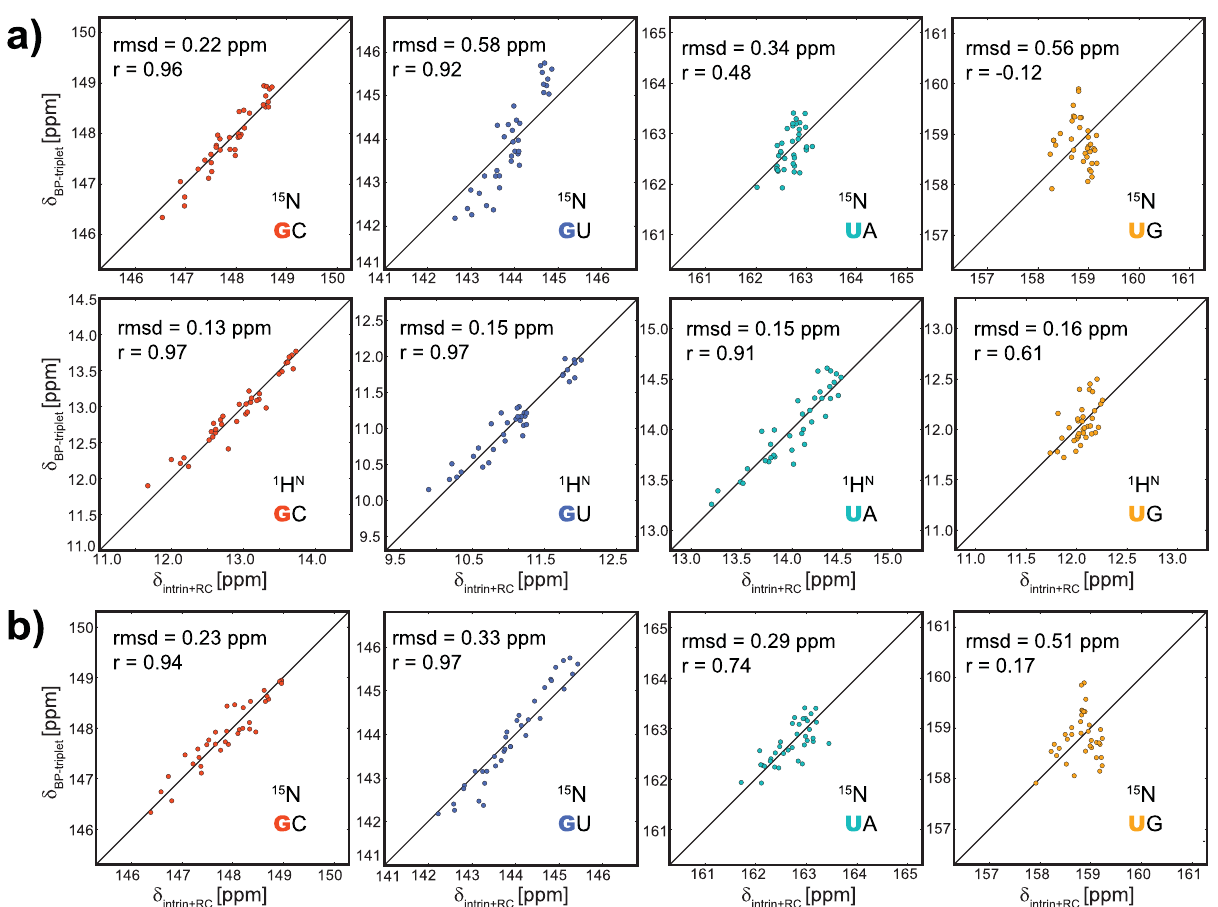
Fig. 3 Correlation between chemical shifts calculated by the semiempirical model and chemical shifts in the BP-triplet lookup table. The structure models were generated by RNAComposer. Chemical shift data in the BP-triplet table are divided into four groups (GC: red; GU: blue; UA: cyan; UG: orange) according to types of the central base pair. a Correlation between chemical shifts calculated by the semiempirical model using original RC parameters (DC set) and chemical shifts in the BP-triplet lookup table. The upper four subplots show the correlation for 15 N, and the lower four show the correlation for 1 H N . b Correlation between 15 N chemical shifts calculated by the semiempirical model using calibrated RC parameters and 15 N chemical shifts in the BP-triplet lookup table. The semiempirical calculation was carried out by summing up the intrinsic chemical shift of the central base pair and RC contributions from two neighboring base pairs. For each subplot, the intrinsic chemical shift was adjusted so that the semiempirical result and the chemical shift data from the BP-triplet table give the same mean value.